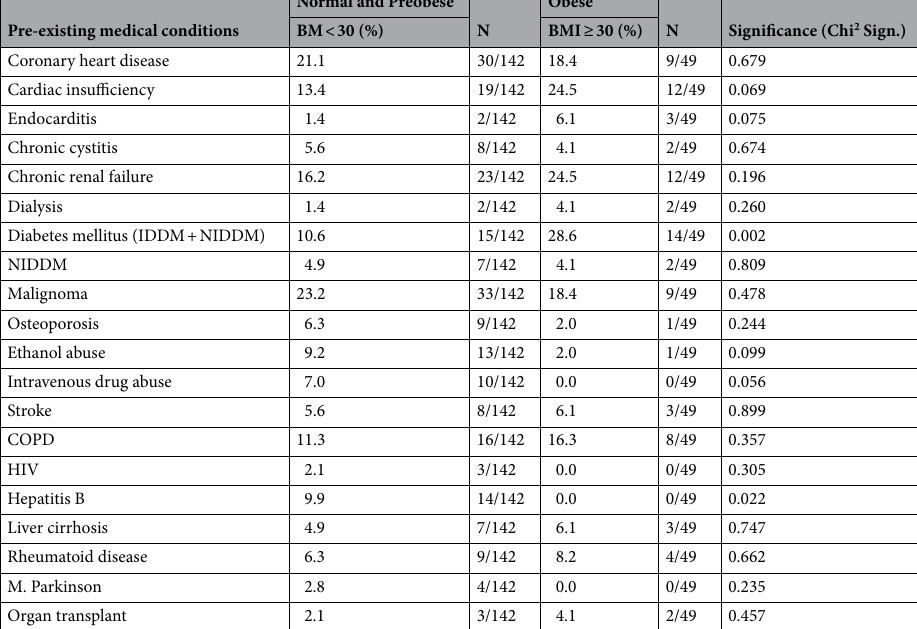
Table 3. Pre-existing medical conditions. Most concomitant diseases appear similarly in both cohorts. Diabetes mellitus (Insulin Dependent Diabetes Mellitus) occurs significantly more often in obese patients, and hepatitis B occurs significantly more often in normal weight people. Cardiac insufficiency and endocarditis occur more often in obese patients (but this is not statistically significant). Ethanol and intravenous drug abuse occur more often in the normal weight